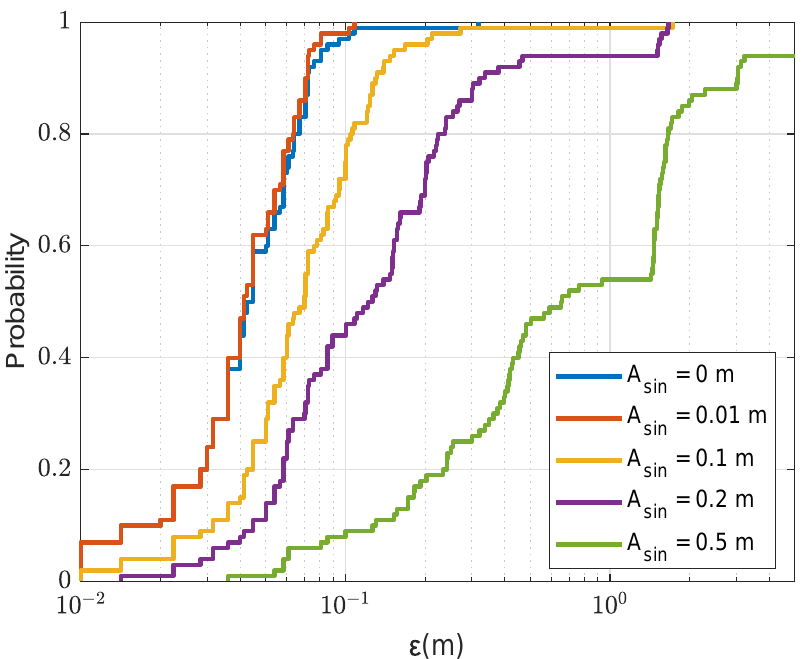
Figure 19. CDF for the localization error ε in the acoustic environment of the sinusoidal surface with the SWellEx-96 SSP against different amplitudes A sin ( A sin = 0 indicates a flat surface); N T = 4; N max = 4, nine points are removed after finding the next coarse AF maximum; the refinement steps, F r = F d = 0.1 m; the size of the refinement area is 4 m × 4 m (as shown in Figure